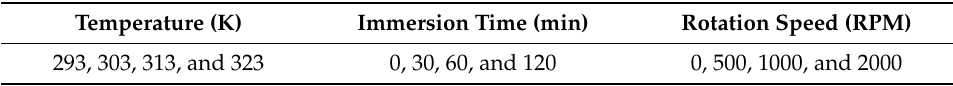
Table 4. Summary of the experimental conditions used in this work.